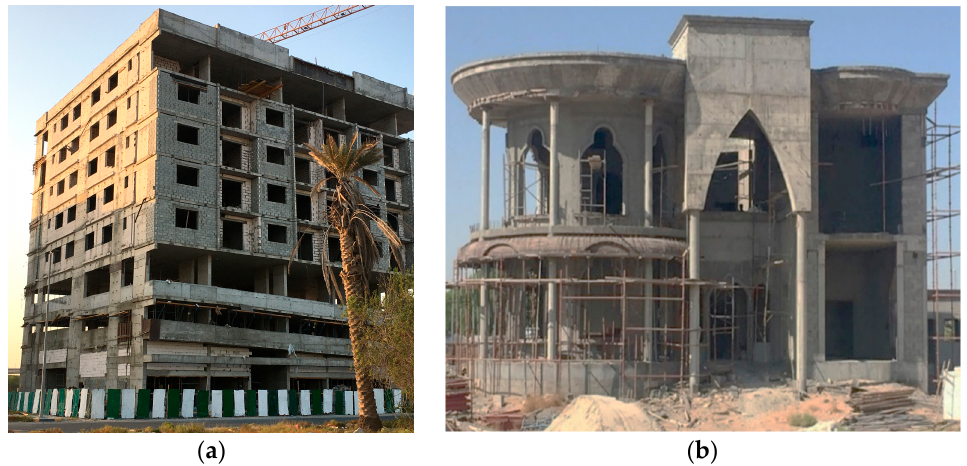
Figure 1. ( a ) A multi-family residential building in Sharjah with commercial premises on the ground floor and a two-level internal car park [own materials]. ( b ) A detached single-family house in Sharjah [own materials].